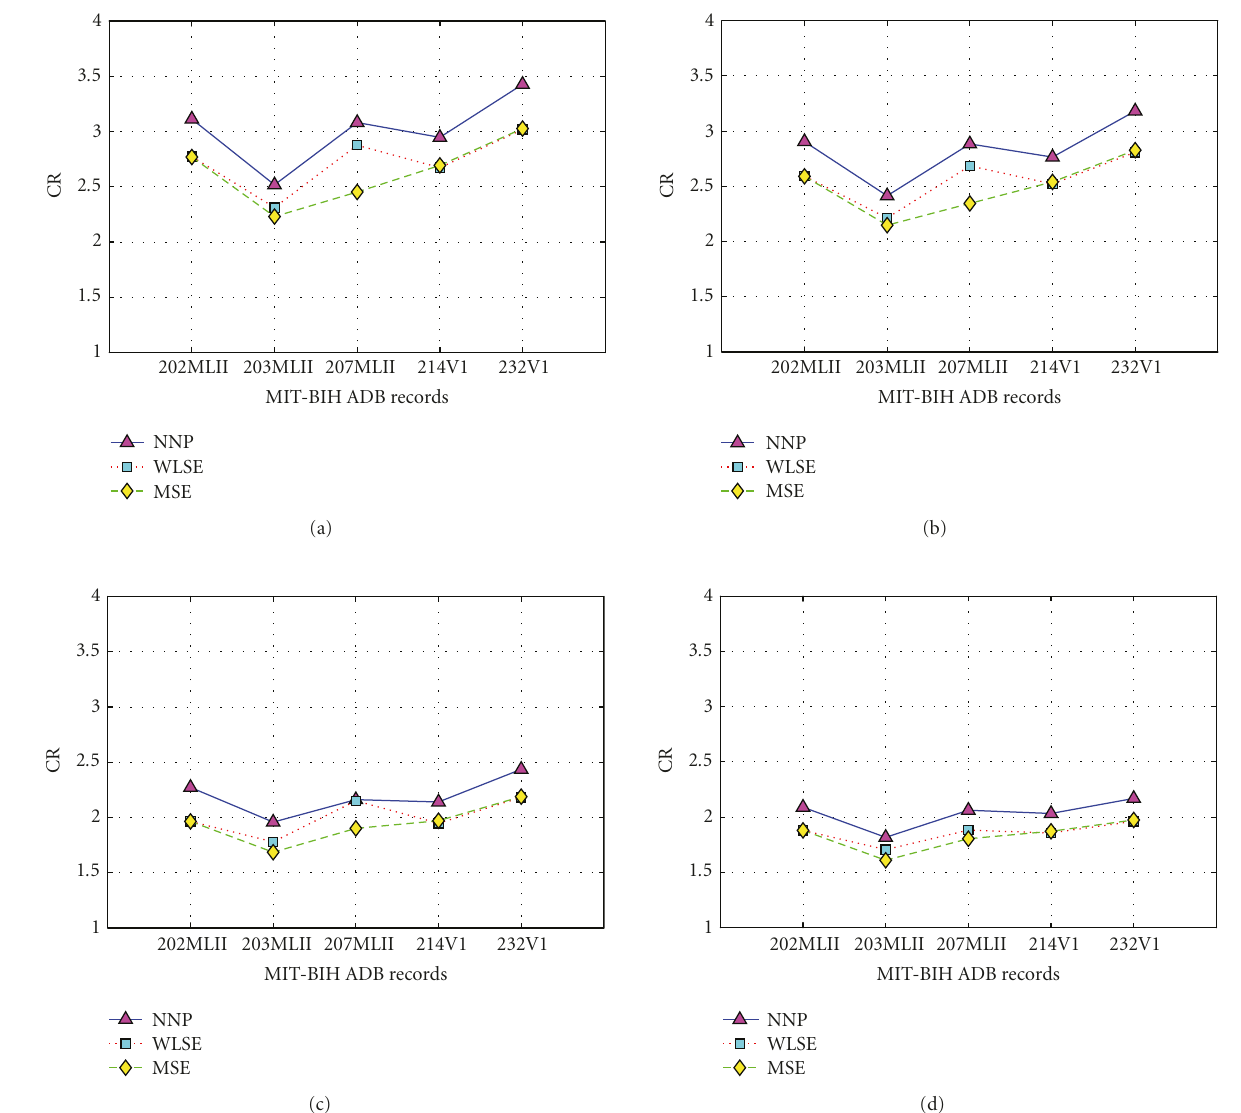
Figure 16: Compression ratio (CR) performance results: (a) PH scheme, (b) PRH scheme, (c) PA scheme, and (d) PRA